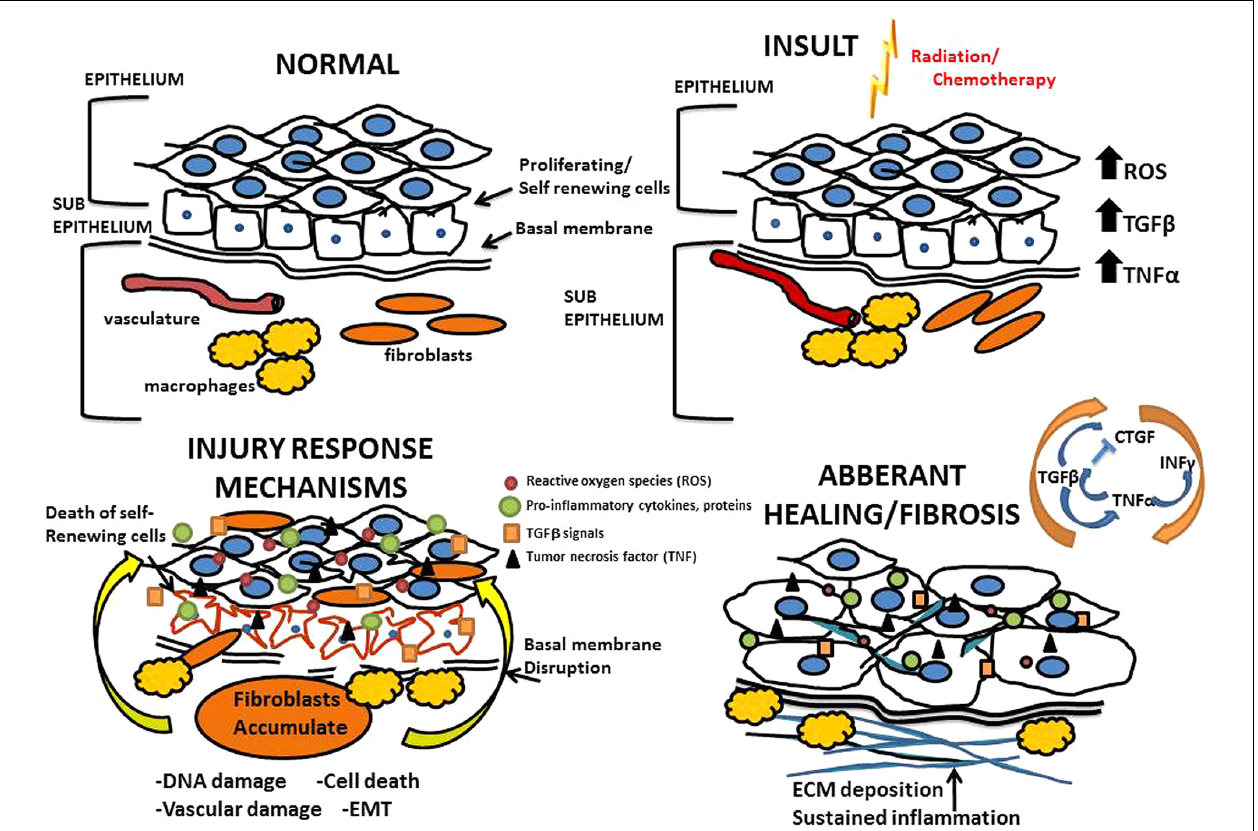
FIGURE 1 | Mechanisms of radiation and chemotherapy-induced fibrosis. Above is an illustration of the processes that drive fibrosis detailing the mechanisms governing the overall tissue changes that occur as a result of radiation and chemotherapy induced injury; progressing from normal tissue to an eventual fibrotic